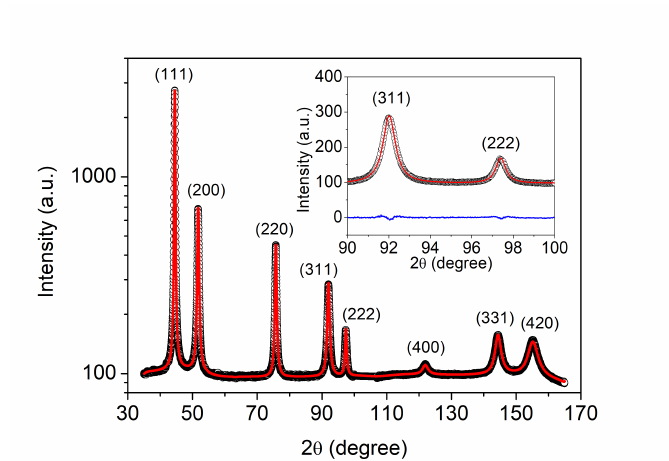
Figure 3. eCMWP fitting on the pattern taken on the “ss” side of the film CYS01. The black open circles and the red solid line represent the measured and the calculated XRD patterns, respectively. The intensity is displayed on a logarithmic scale. The inset shows a magnified part of the pattern with linear intensity scale. The difference between the measured and the calculated data is represented by the blue